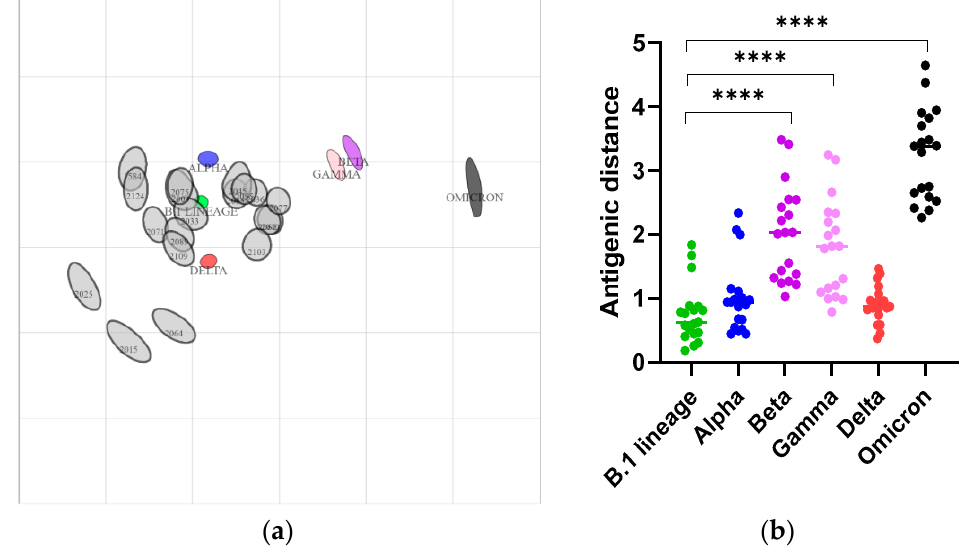
Figure 3. Construction of antigen cartography based on the NT 50 of serum samples collected from deer. ( a) Two-dimensional antigenic map of the SARS-CoV-2 B.1 lineage, the Alpha, Beta, Gamma, Delta, and Omicron variants, and the serum samples collected from the deer. The SARS-CoV-2 strains and serum samples are shown as blobs, as estimated using stress parameter 0.1. The SARS-CoV-2 B.1 lineage, and the Alpha, Beta, Gamma, Delta, and Omicron variants are indicated in green,